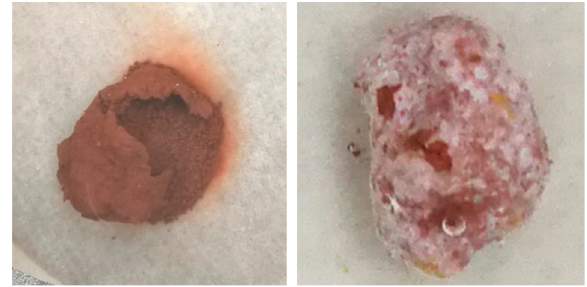
Figure 8. Aggregates treated with 0.5% ADNB (left) and 5.0% ADNB (right).